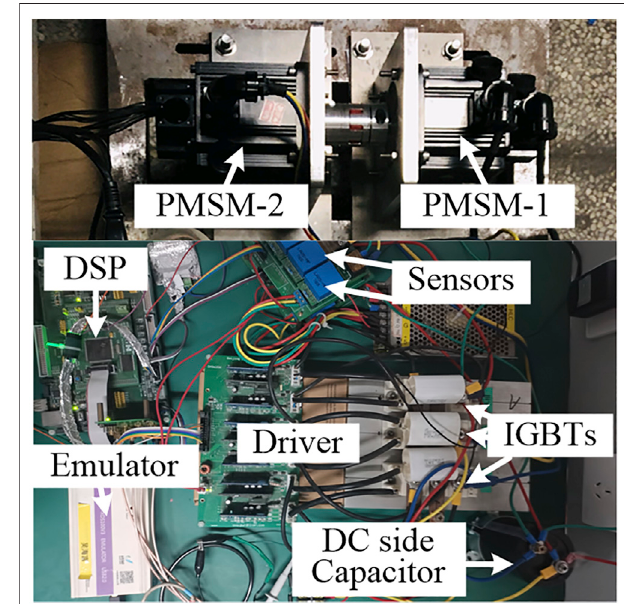
FIGURE 15 | Experimental platform.